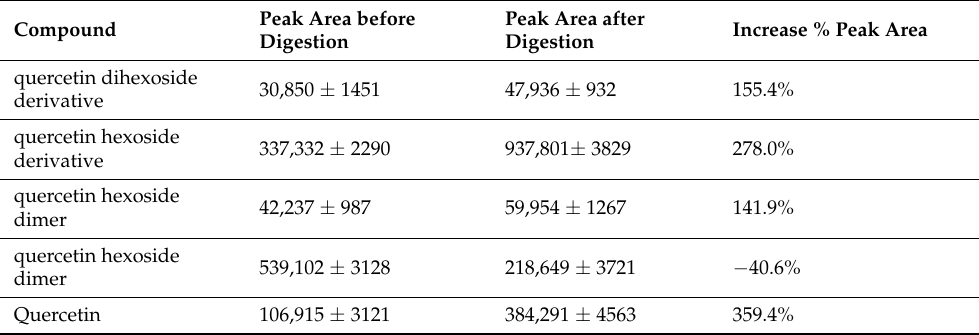
Table 5. Mean relative peak area and percentage increase of quercetin and its derivatives identified in A. cepa Golden variety tunic extract before and after gastro-duodenal digestion process.